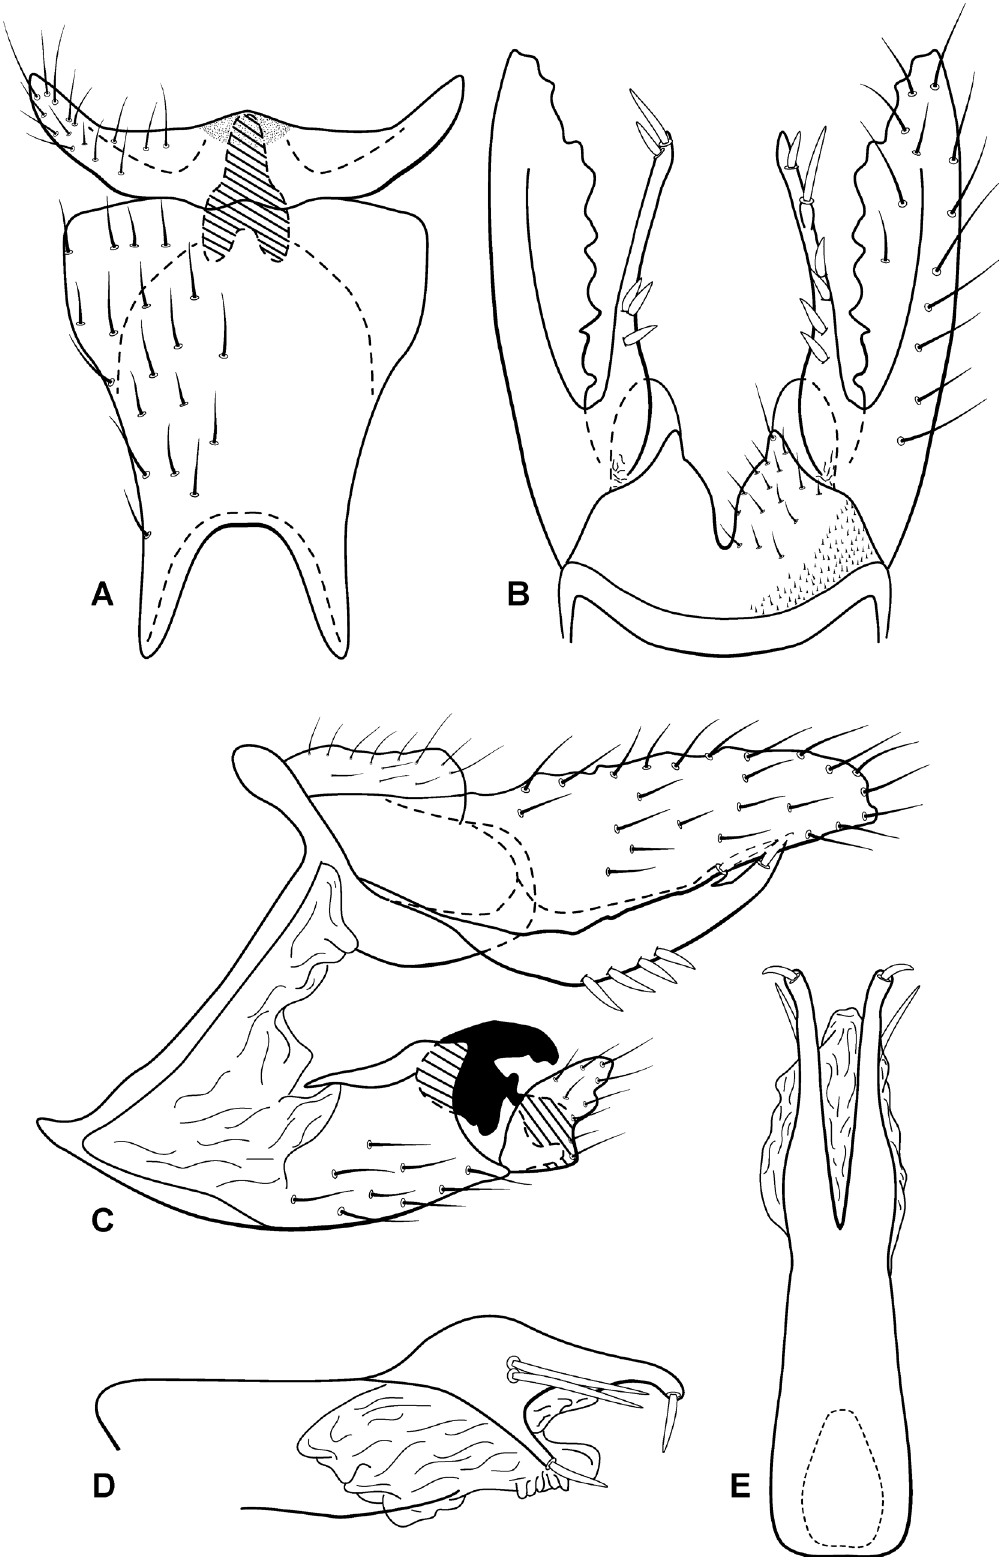
Fig. 12. Austrotinodes vanzolinii sp. nov., male genitalia. A . Ventral view. B . Dorsal view. C . Left lateral view. D . Phallic apparatus, left lateral view. E . Phallic apparatus, dorsal